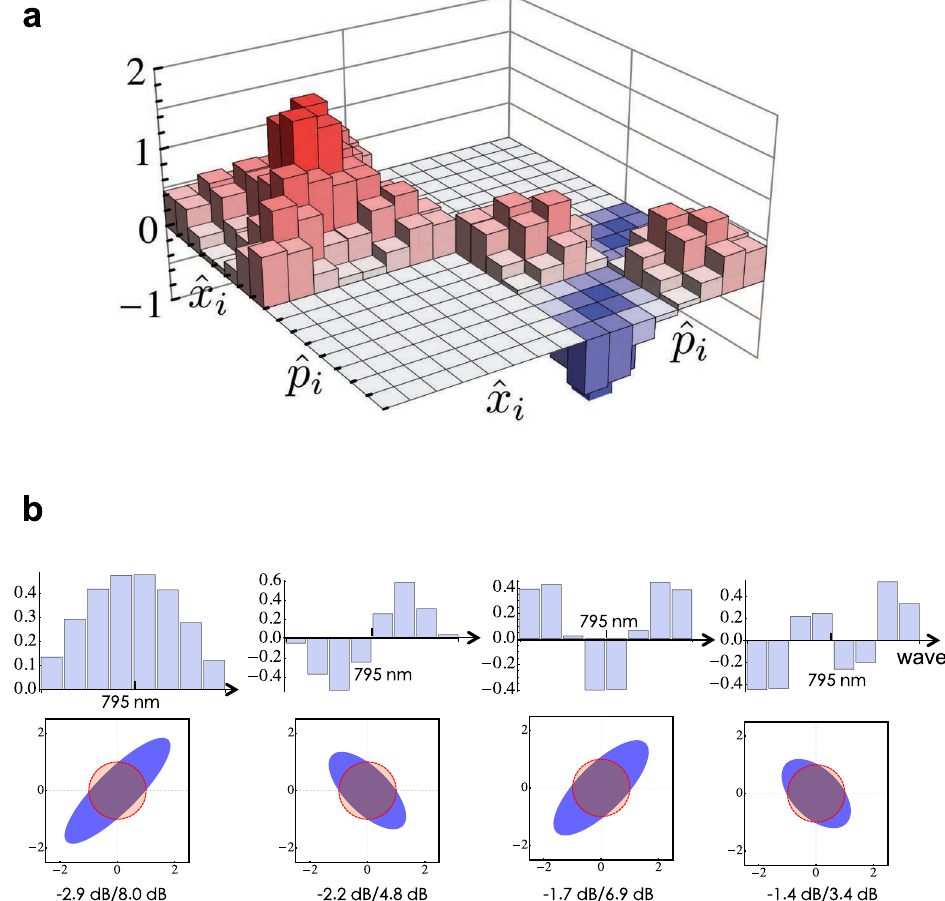
Fig. 4 The quantum state of the multimode quantum resource. a Eight-partite full covariance matrix of the multimode quantum resource via multi-pixel homodyne measurement. All the amplitude or phase quadrature of different color components, ^ x i or ^ p i , are simultaneously interrogated, and the spectrum of the local oscillator is divided into eight frequency bands of equivalent width. The covariance matrix ^ ζ ^ ζ h ^ ζ þ ^ ζ i (cid:2) h ^ ζ ih ^ ζ i , where ^ ζ ¼ ^ x i ; ^ p elements are de fi ned as 1 i j j i i j i i . The shot-noise contribution has been subtracted from the diagonal for better 2 visibility, and the noise level is normalized to vacuum noise (i.e. shot noise is equal to 1). Note that our squeezer presents no amplitude-phase cross-correlation, hence the corresponding parts in the full covariance matrix are all zero. b The squeezing values of the four leading spectral modes (up) and the corresponding squeezing ellipse in quadrature phase space. The red circles represent the shot noise, and the odd-order and even-order modes are squeezed in amplitude and phase quadrature, respectively. Both ( a and b ) were only corrected for electrical dark and bandwidth parameters estimation are enhanced simuta- are simultaneously obtained by reconstructing an alternative photocurrent superposition (i.e., the sum of the individual neously. The corresponding shot-noise limited sensitivity of photocurrents which corresponds to the mean- fi eld mode). In mean energy shifts is δ N SQL ≈ 2 × 10 8 photons s (cid:2) 1 2 , and with practice, the modulation of the center frequency within the laser considering the global ef fi ciency, the practical sensitivity is cavity also causes an energy variation and an spectral bandwidth δ N ≈ 1.7 × 10 8 photons s (cid:2) 1 2 . According to the SNR ratio in mesa variation. According to Eq. (3), all variations in energy, frequency, Fig. 5, the quantum-enhanced sensitivity for the mean energy and spectral bandwidth can be retrieved by post-processing the shift is δ N Quan ≈ 1.4 × 10 8 photons s (cid:2) 1 2 , which is ~19% improved mean- fi eld mode and the central frequency mode as well as the compared to the one with shot-noise limited. For a measure- bandwidth mode, respectively, seen in Fig. 5a. As seen in Fig. 5b, ment time of 20 μ s, the actual sensitivities are 7.5 × 10 5 photons c, while the sensitivity for determining frequency deviations is and 6.1 × 10 5 photons for shot-noise limited and quantum- enhanced with a squeezing resource, the sensitivity for the enhanced, respectively. Similarly, the shot-noise limited sensi- measurements of energy and bandwidth fl uctuations are (cid:4) 39.4 kHz Hz (cid:2) 1 tivity for the spectral bandwidth are δ Δ ω ð Þ 2 , degraded with respect to the shot-noise limit. This is due to SQL and considering the global ef fi ciency, the actual sensitivity is the fact that the modes corresponding to these two spectral δ Δ ω ð Þ (cid:4) 47.1 kHz Hz (cid:2) 1 2 . The quantum-enhanced sensitivity is structures are squeezed in opposite quadratures (i.e., the SQL δ Δ ω ð Þ (cid:4) 33.4 kHz Hz (cid:2) 1 2 , which is ~29% improved compared frequency mode is squeezed while the mean- fi eld mode and Quan to the shot-noise limited one. And for a measurement time of the bandwidth mode are anti-squeezed). Note that the results 20 μ s, the actual sensitivities are 10.5 and 7.46 MHz for shot noise for the central frequency are similar to that in the previous and quantum-enhanced light, respectively. Note that as the central frequency mode is orthogonal to the energy mode, our MPSR scheme has no fundamental limit to realize all the three